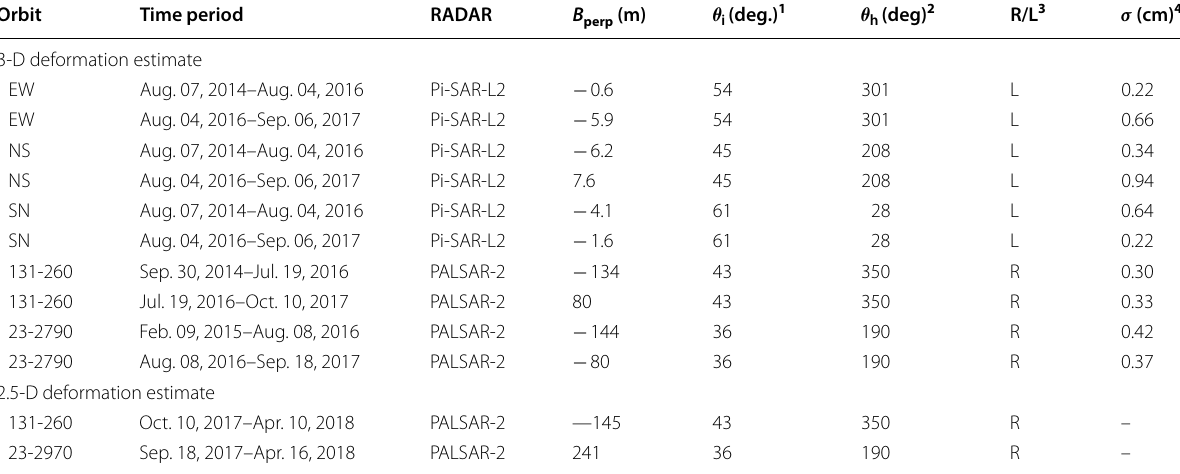
Table 1 Interferograms used to estimate the 3-D deformation